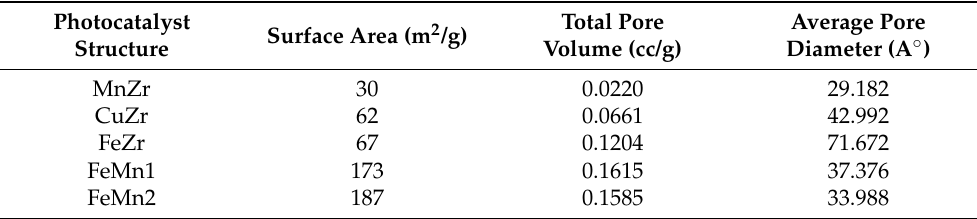
Figure 4. TEM images of doped systems ( a ) FeMn1, ( b ) FeMn2, ( c ) FeCu1, ( d ) FeCu2, ( e ) ZrW1, and ( f ) ZrW2. Table 4. The values of the surface area, total pore volume, and average pore diameter of prepared